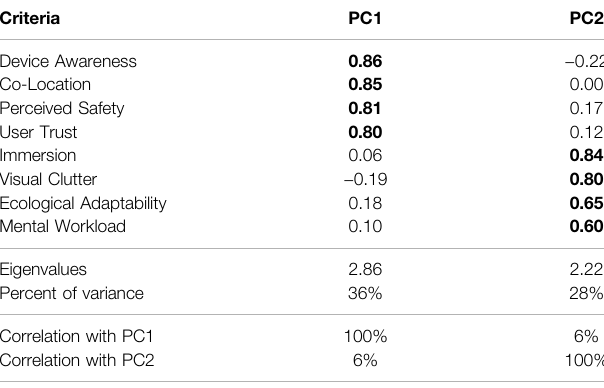
TheboldvalueswerehighlightedtoshowtheirpertinencetoPC1andPC2.The fi rstfour highlighted values (top to bottom) correspond to PC1 which integrates the Device Awareness, Co-Location, Perceived Safety, and User trust criteria. The rest of the highlighted values correspond to PC2, which integrates Immersion, Visual Clutter, Ecological Adaptability, and Mental